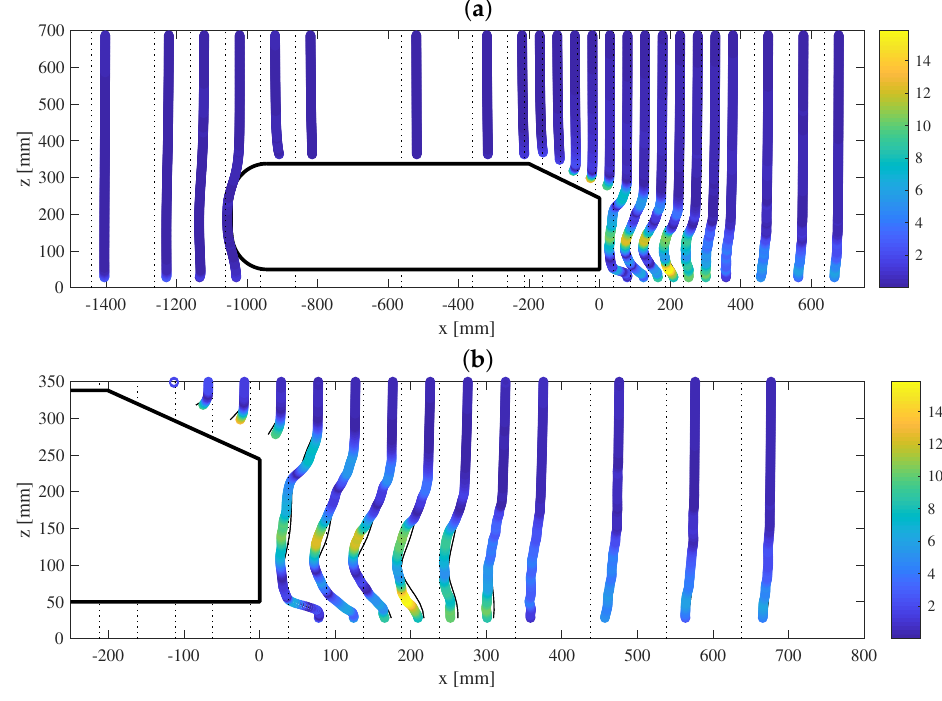
Figure 11. Velocity error for the LES turbulence model. Experimental data are presented as black lines. The unit of the colormap is meter per second (m/s). ( a ) General view; ( b ) zoom at the back of the Ahmed